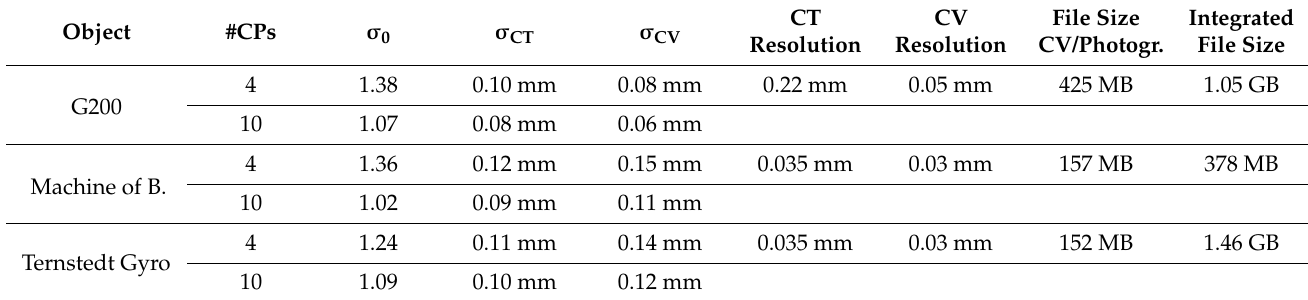
Table 4. Precision values and file sizes of some Gyrolog 3D digital twins.